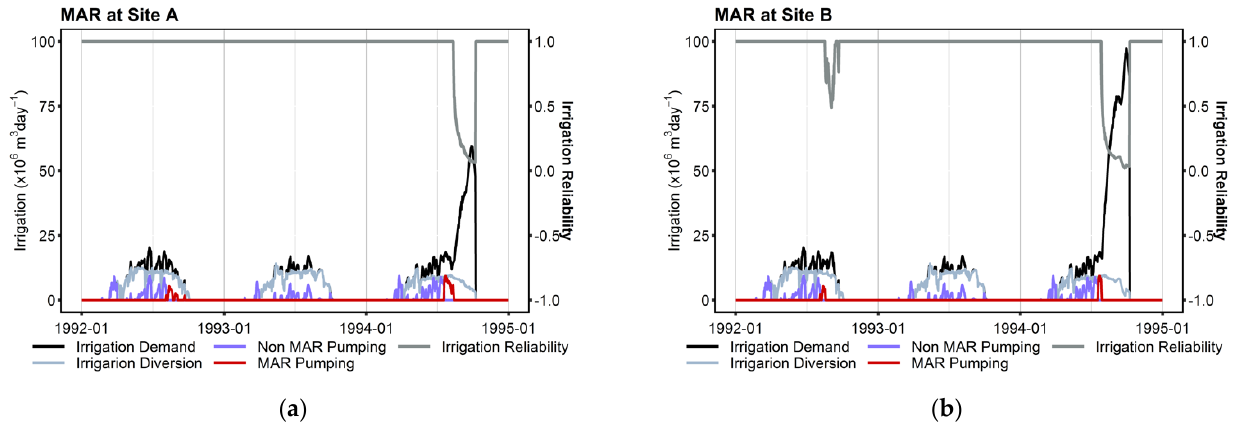
Figure 13. Total irrigation demand and three supply sources during multi-year droughts if MAR was implemented in year 1990 at ( a ) Site A and ( b ) Site B.